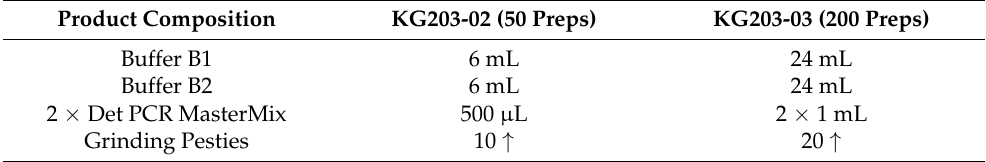
Table 1. DNA extraction kit product content.